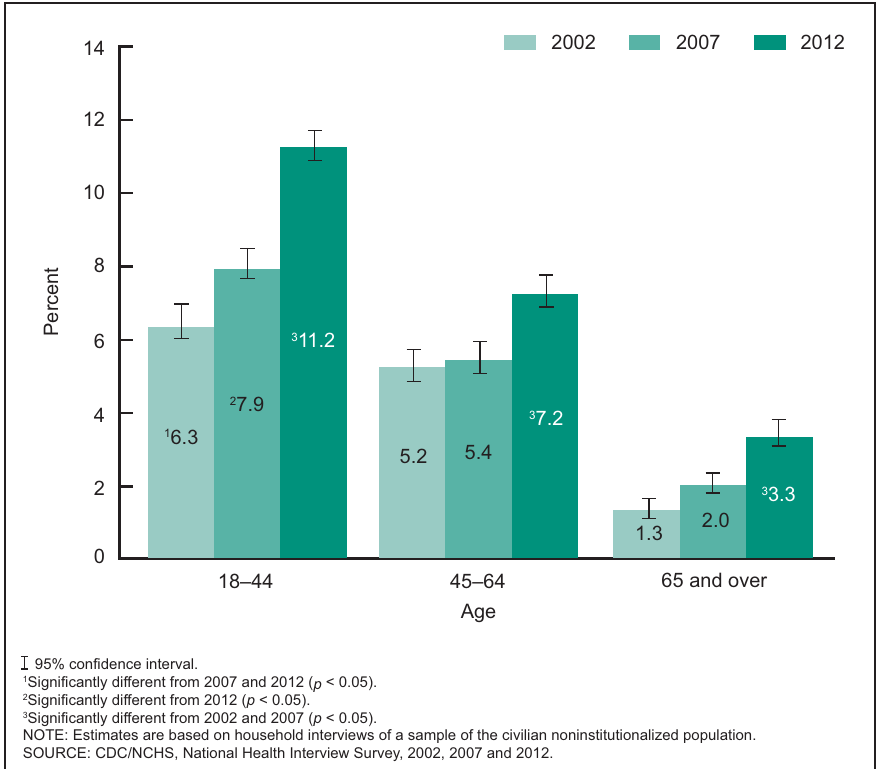
Figure 2. Use of yoga among adults in the past 12 months, by age group: United States, 2002, 2007, and 2012